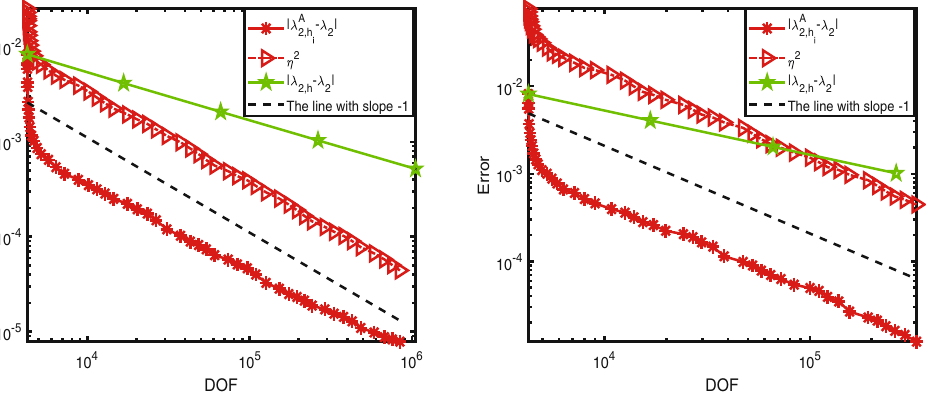
Figure 5: Error comparison of the second eigenvalue for ( 2.1 ) – ( 2.2 ) on the square with a slit ( the left: k = 1, n ( x ) = 4, the right: k = 1, n ( x ) = 4 + 4 i )